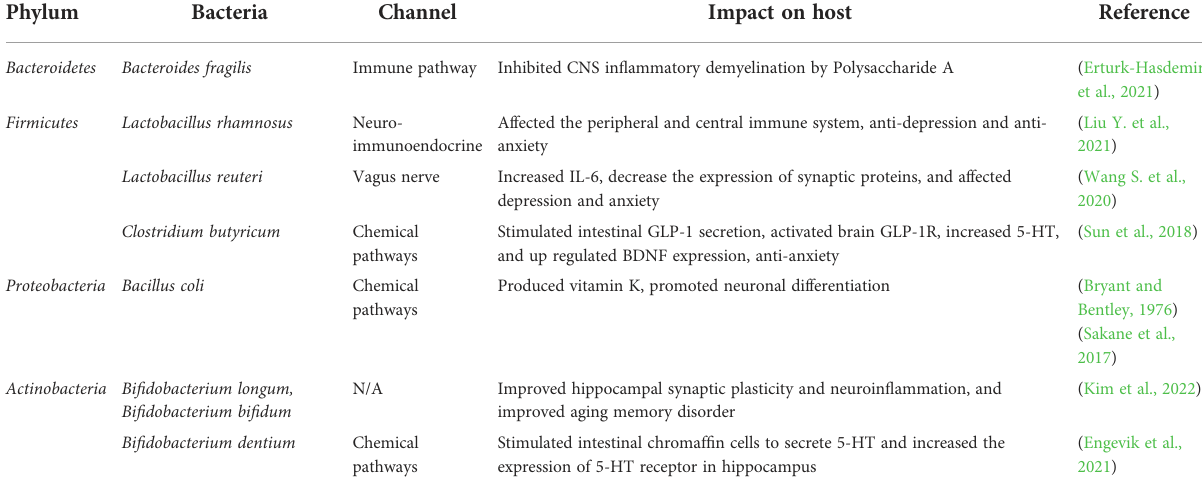
TABLE 2 Effects of Different Phylum Gut Microbiota on Central Nervous System of